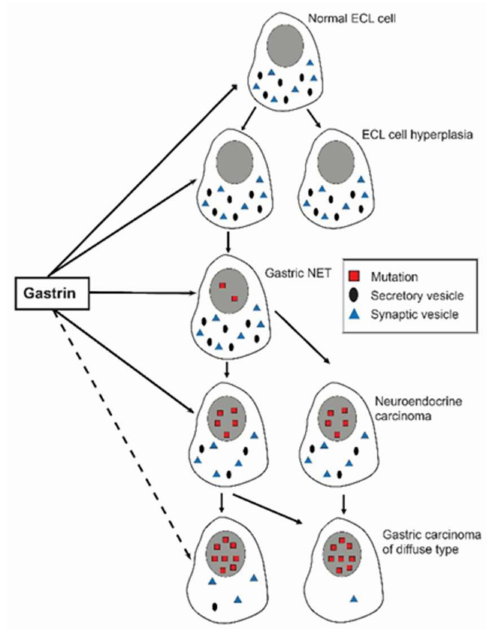
Figure 1. Upon chronic gastrin overstimulation the ECL cell gradually loses specific traits like secretory granules as well as receptors (With permission from ref